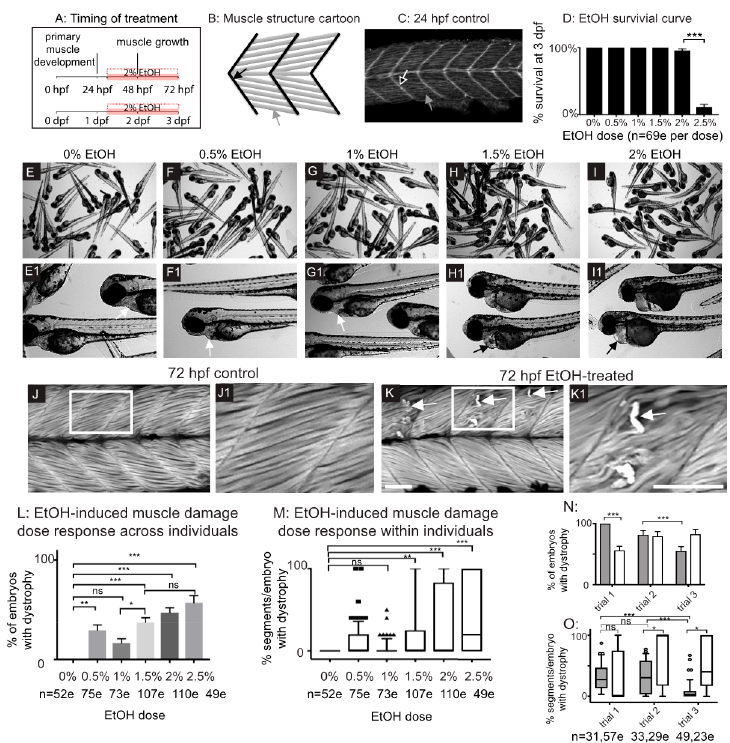
Figure 1. Late embryonic exposure to EtOH causes muscle damage in zebrafish. ( A ) Zebrafish muscle development timeline showing that 2% EtOH was administered after primary muscle development is complete. ( B ) Cartoon showing zebrafish muscle structure. Elongated myofibers (gray arrow) attach at the myotendinous junction (MTJ) (black arrow). ( C ) Control embryo. Muscle fibers have elongated (gray arrow) and attached to the MTJ (black arrow outlined in white) by 24 hpf. ( D ) Quantification of survival at 72 hpf following continuous treatment with one of six different doses of EtOH from 30 to 72 hpf. ( E – I1 ) Brightfield images of 72 hpf zebrafish treated with one of six different doses of EtOH. Numbered panels are higher magnification images of zebrafish treated with the same EtOH dose as the corresponding lettered panels. ( E – E1 ) 0% EtOH. Note normal heart morphology ( E1 , white arrow). ( F – F1 ) 0.5% EtOH. Note normal heart morphology ( F1 , white arrow). ( G – G1 ) 1% EtOH. Note normal heart morphology ( G1 , white arrow). ( H – H1 ) 1.5% EtOH. Note pericardial edema ( H1 , black arrow). ( I – I1 ) 2% EtOH. Note pericardial edema ( I1 , black arrow). ( J – K1 ) Anterior left, dorsal-top, side-mounted, 72 hpf embryos stained with phalloidin (white) to visualize actin. White boxes in J and K correspond to zoomed-in, numbered panels J1 and K1 , respectively. ( J – J1 ) Control embryo. Muscle fibers remain attached to the MTJ. ( K – K1 ) Embryo treated continuously with 2% EtOH from 30 to 72 hpf. White arrows indicate muscle fibers that have detached from the MTJ. ( L ) Quantification of the percent of EtOH-treated embryos at each of the EtOH treatment doses that displayed one or more fiber detachments. ( M ) Quantification of the percent of imaged segments with fiber detachments per embryo across the six different EtOH treatment doses. ( N – O ) Quantification of the variability in EtOH-induced fiber detachments across experimental replicates. ( N ) Percent of EtOH-treated embryos with at least one fiber detachment across three trials with either 2% EtOH diluted from 95% stock (gray bars) or 2% EtOH diluted from 100% stock (white bars). ( O ) Percent of imaged segments per embryo with fiber detachments across three trials with either 2% EtOH diluted from 95% stock (gray boxes) or 2% EtOH diluted from 100% stock (white boxes). Note the persistence of variability in muscle damage across three trials regardless of EtOH stock solution used. Scale bars are 50 micrometers. “e” = embryo. Error bars are standard error of the mean and whiskers